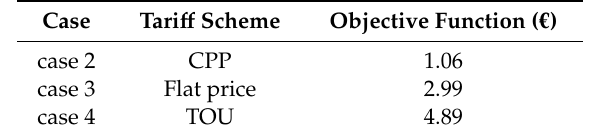
Table 1. Objective function results from the di ff erent tari ff s schemes: Revenue in Euros.